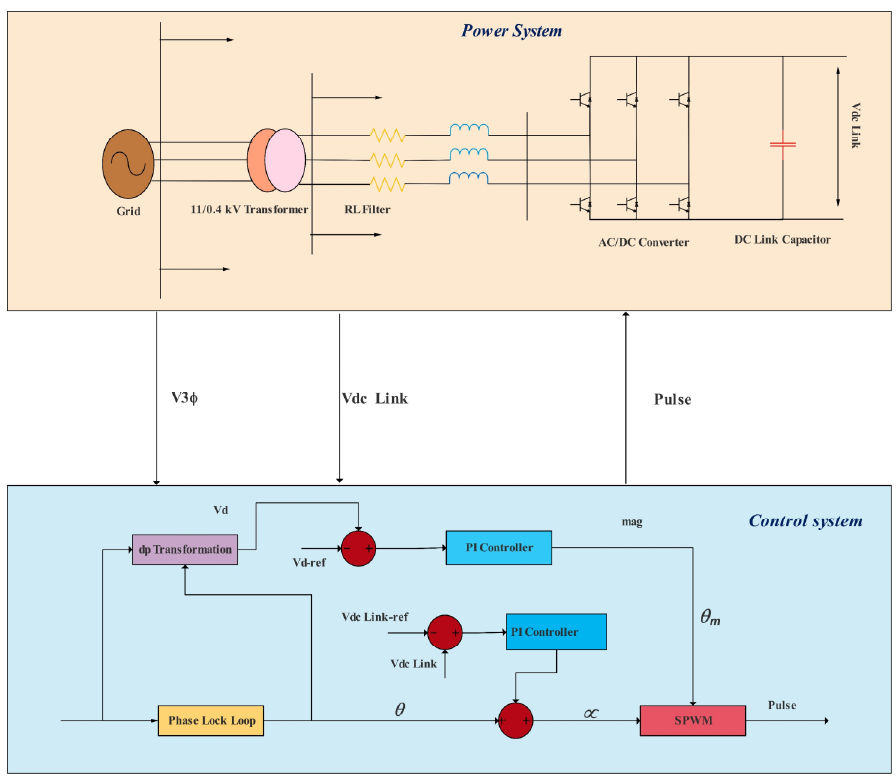
Figure 3. Block diagram of comprehensive AC/DC converter control.